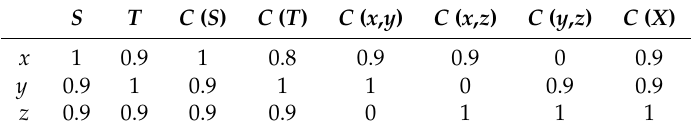
Table 6. The choice function and feasible subsets in Example 6. We omit brackets for simplicity. S T C ( S ) C ( T ) C ( x , y ) C ( x , z ) C ( y , z ) C ( X